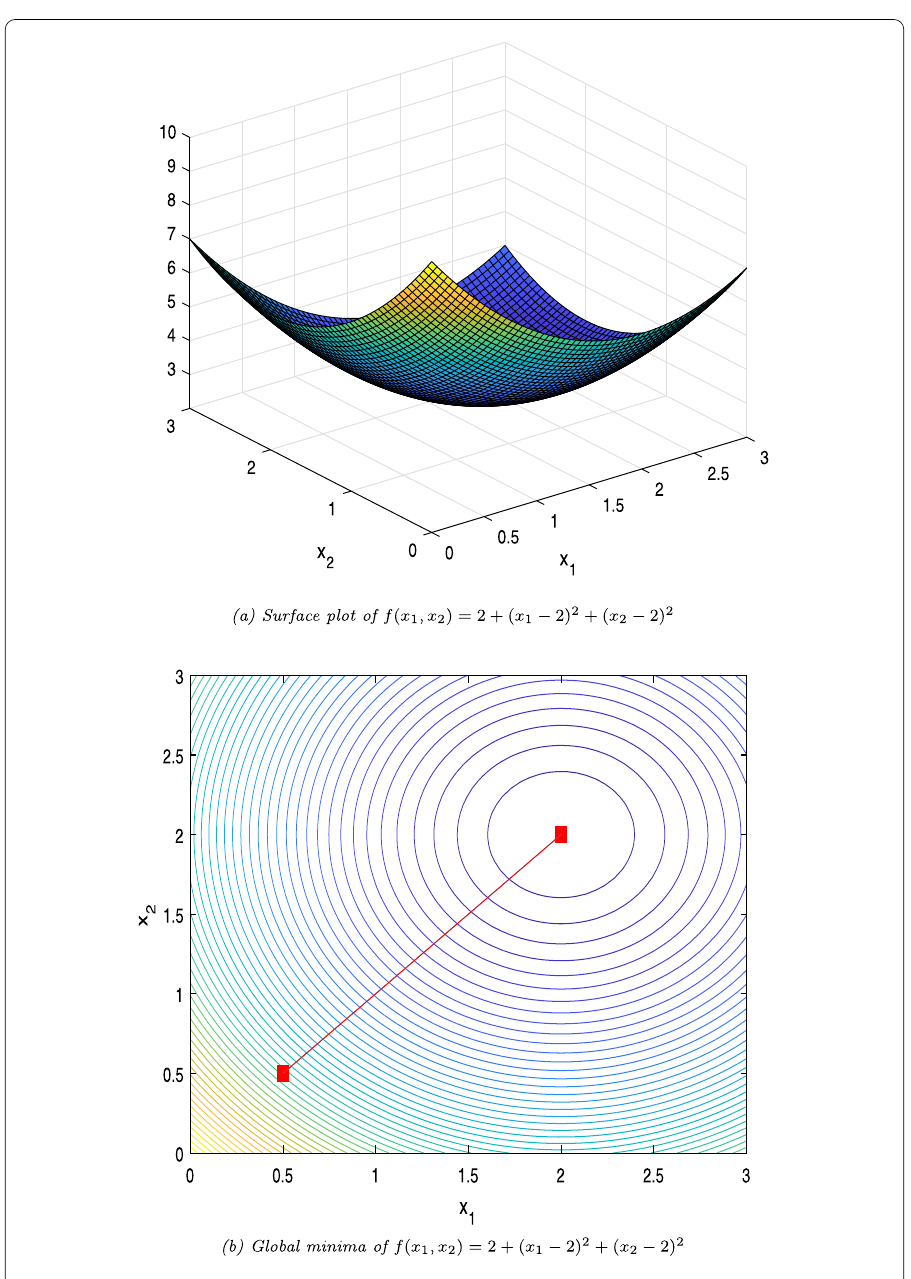
Figure 5 Visualization of Example